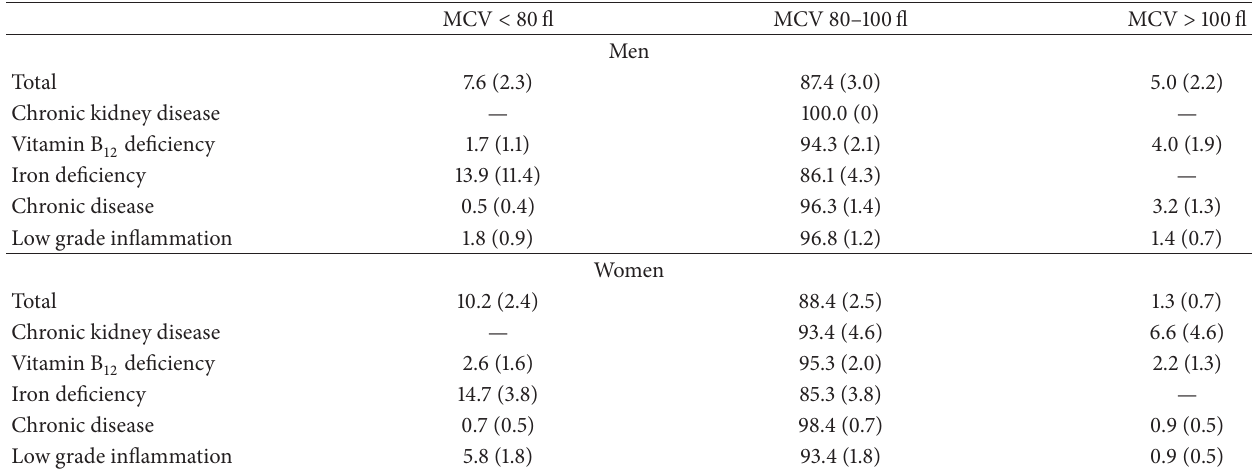
Table 4: MCV distribution among older adults with selected causes of anemia in